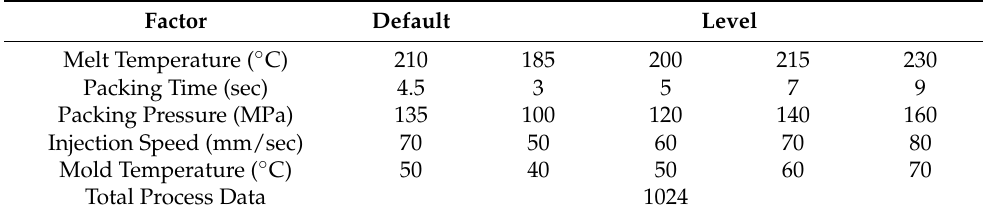
Figure 12. Measurement position of the round plate model. Table 10. Training data for the round plate (CAE-1024).